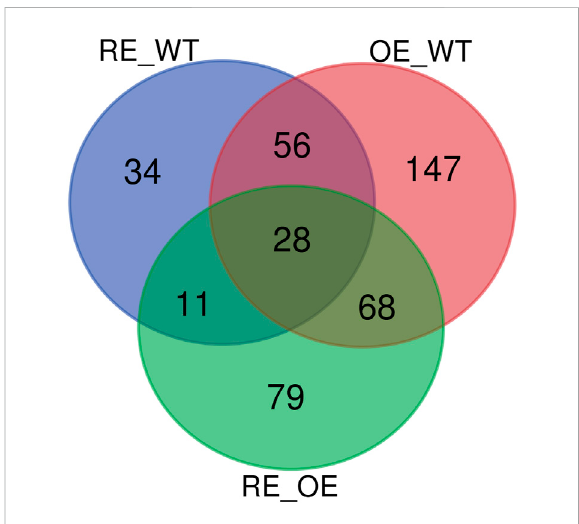
FIGURE 7 Wayne diagram of differential metabolites in three